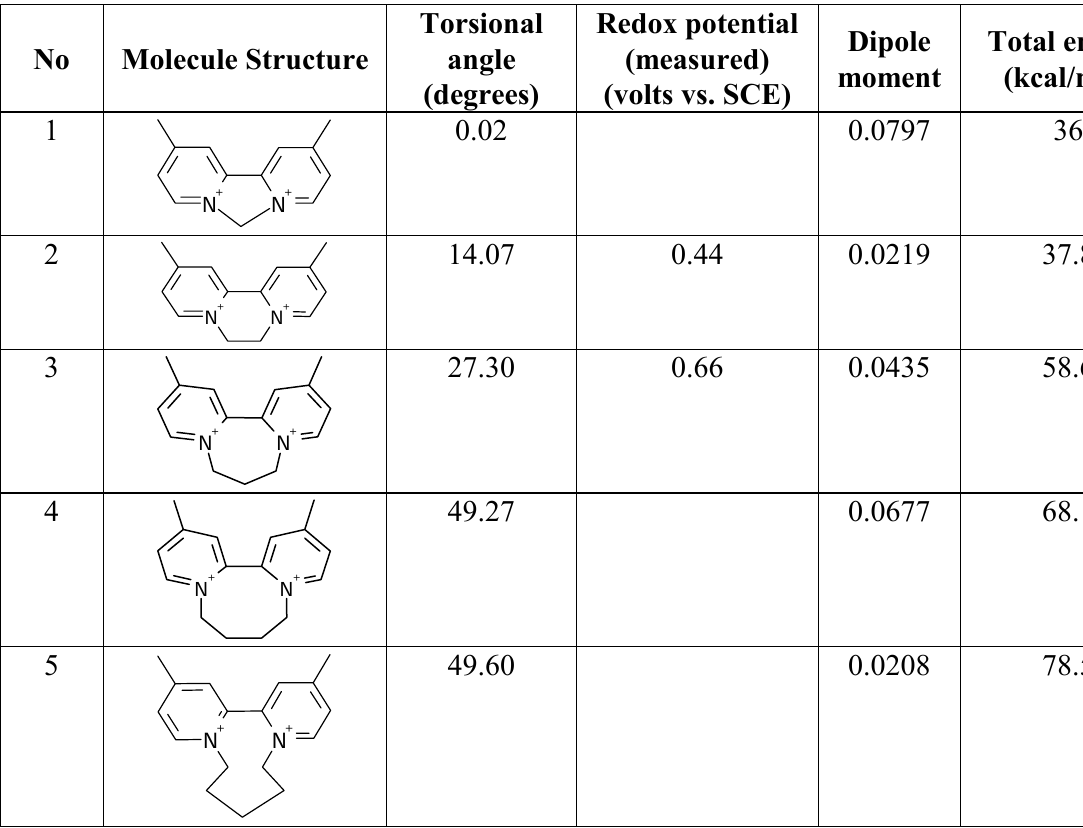
Table 1. Molecular structures and torsional